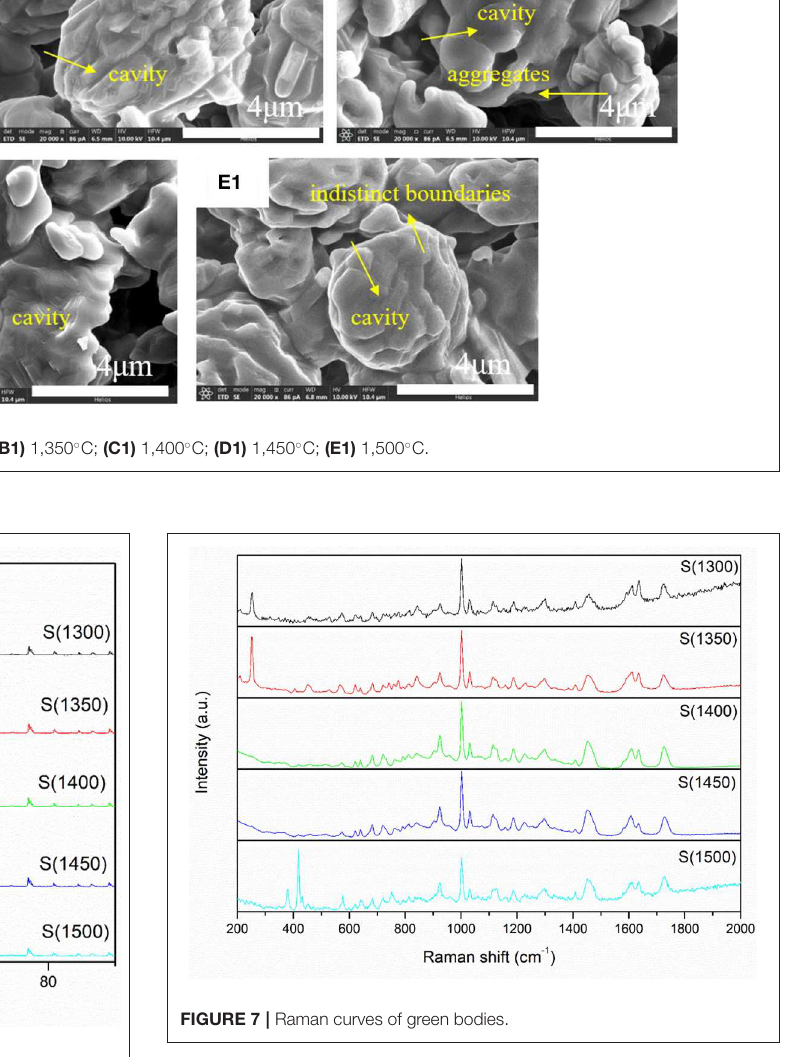
FIGURE 6 | XRD curves of alumina ceramics.